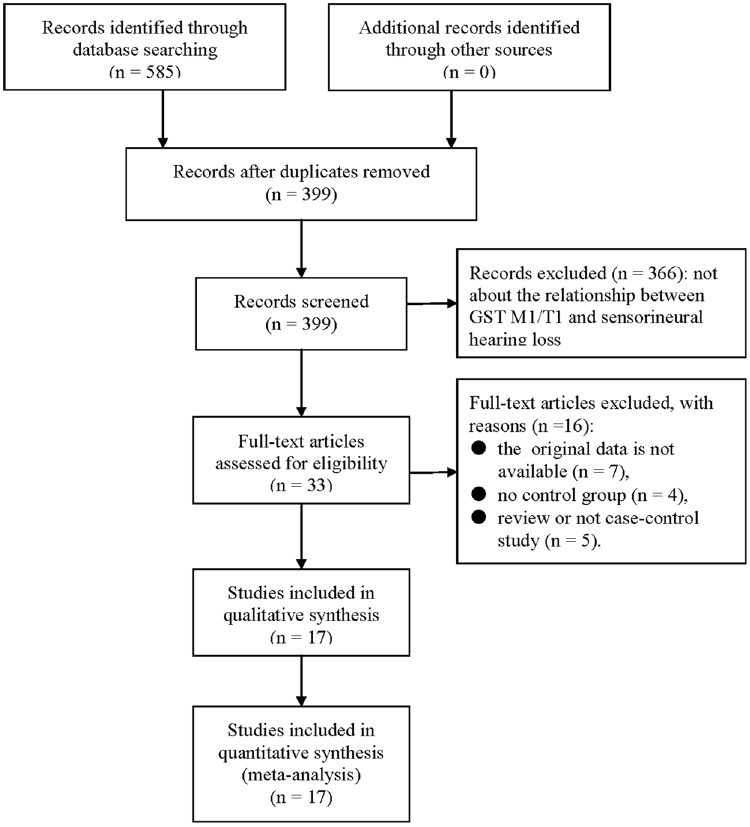
Figure 1. Flow diagram of the study selection